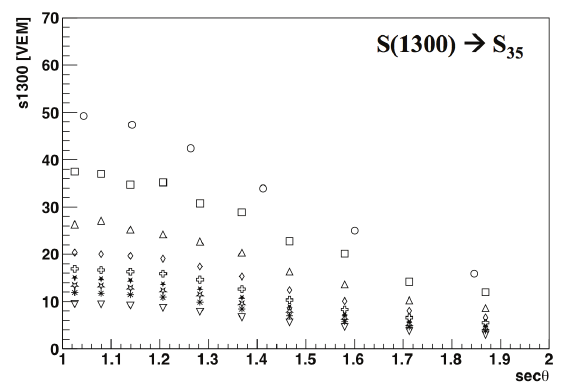
Figure 7. Attenuation curves of S (1300) for di ff erent intensities.